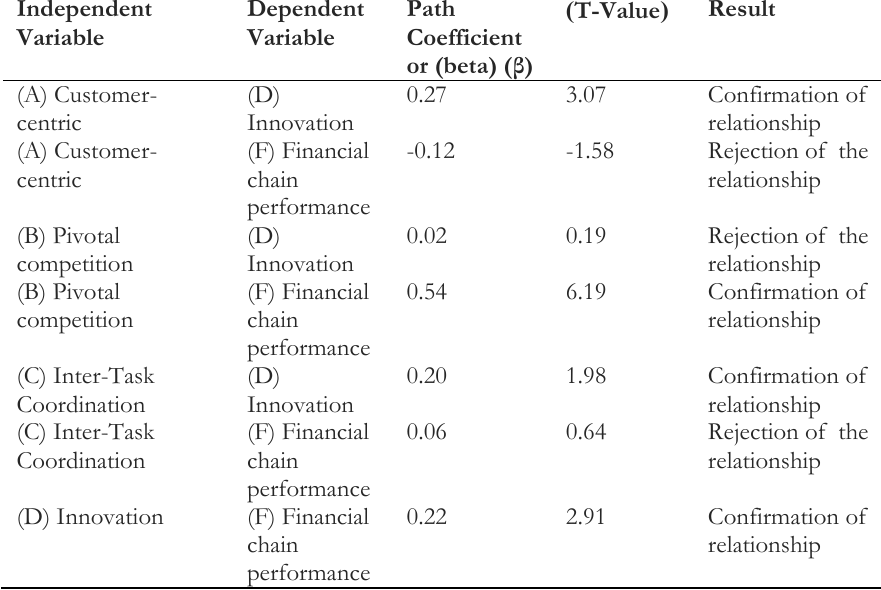
Table 8. Values of Beta and T-Value of the structural